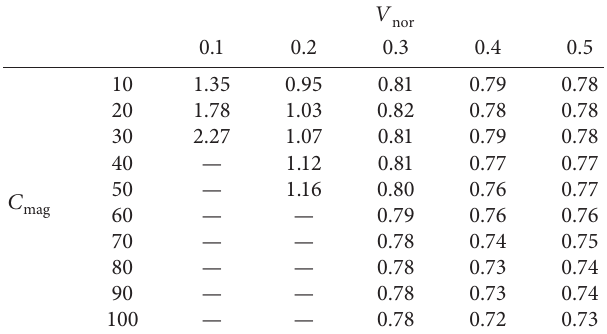
Table 6: Underlying market volatility (× 10 − 3 )